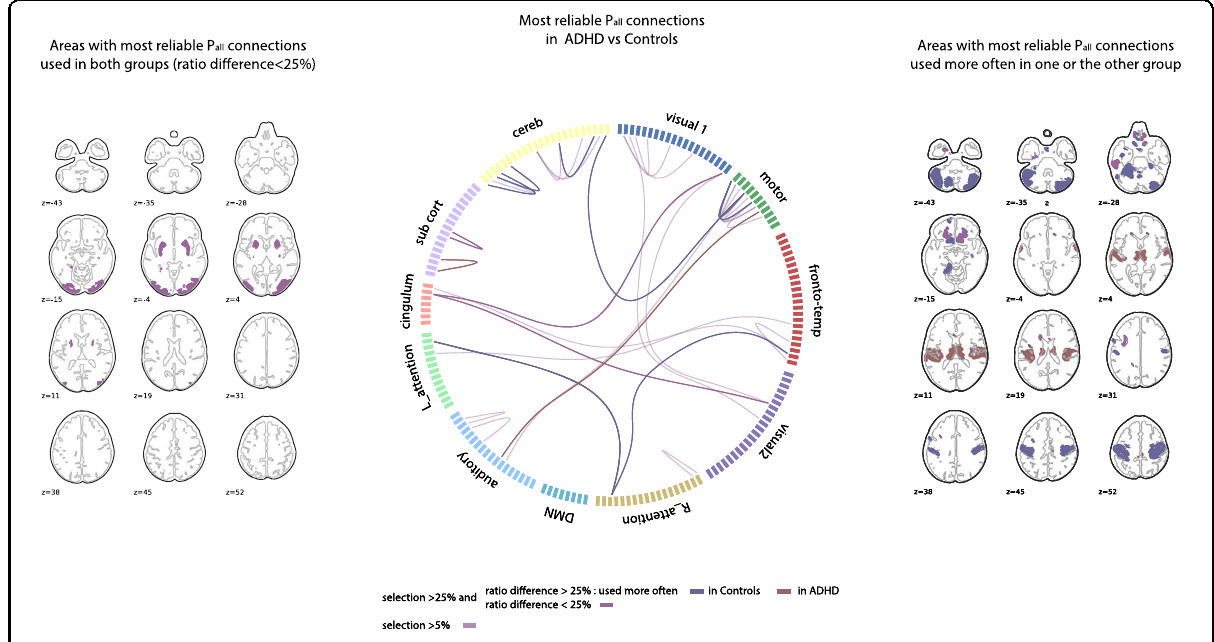
Fig. 3 Representation of areas with most reproducible P all connections comparing ADHD and Control groups. The brain slices on the left show areas with at least one connection used reproducibly (>50% of selection and ratio difference <25%) in both groups. The circular connectivity plot represents all connections selected >50% as P all in one of the two compared groups across bootstraps. Within these strongly reproducible P all connections, the ones used most often in one group are represented with full color of that group (ratio difference >25%) (red for ADHD, blue for Controls). The brain slices on the right represent the brain areas associated to the connections used more often in one group. If an area has connections used in each group, its color is a blend of the compared group colors (purple).